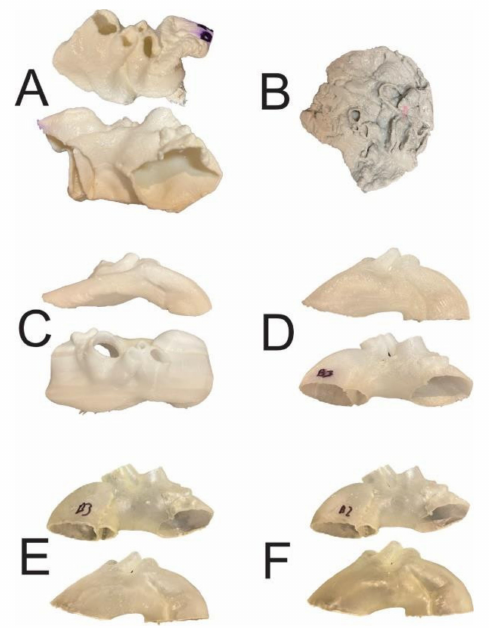
Figure 1. The 3D aortic templates after sterilization in 121 ◦ C autoclave. Templates made of PLA ( A ), PETG ( B ), and PP ( C ) were affected by significant deformations, whereas those made of nylon ( D ), rigid ( E ), and flexible resins ( F ) were intact. PLA—polylactic acid; PETG—polyethylene terephthalate glycol; PP—polypropylene. Table 1. Microbial culture results and the mean differences in geometry between pre- and post- sterilization aortic templates made of polylactic acid (PLA), polyethylene terephthalate glycol (PETG), nylon, polypropylene (PP), rigid resin, and flexible